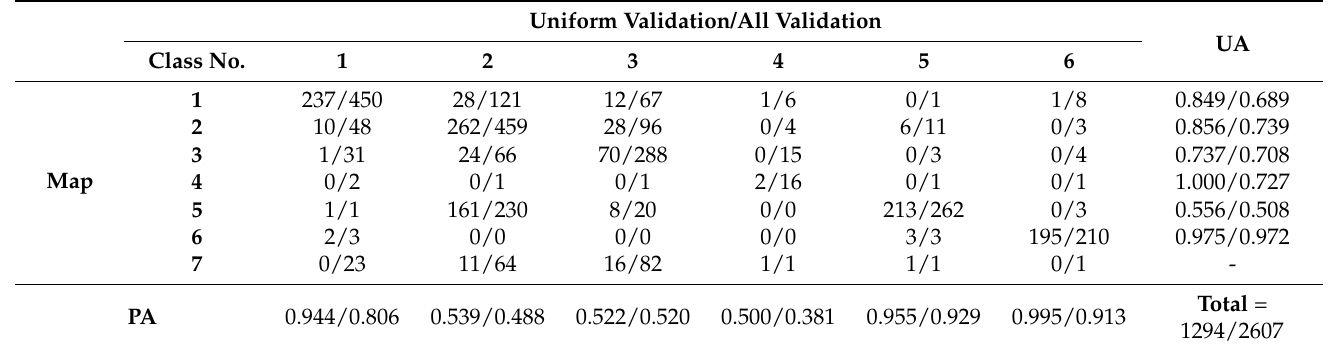
Table 12. Confusion matrix for GLCNMO in 990 m